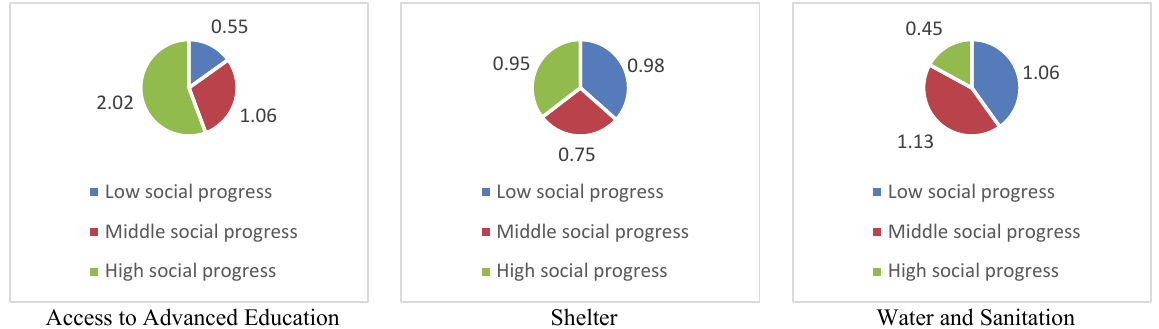
Fig. 2. 10% increase in GDP per capita across different groups (Social Progress Imperative, 2015, p.